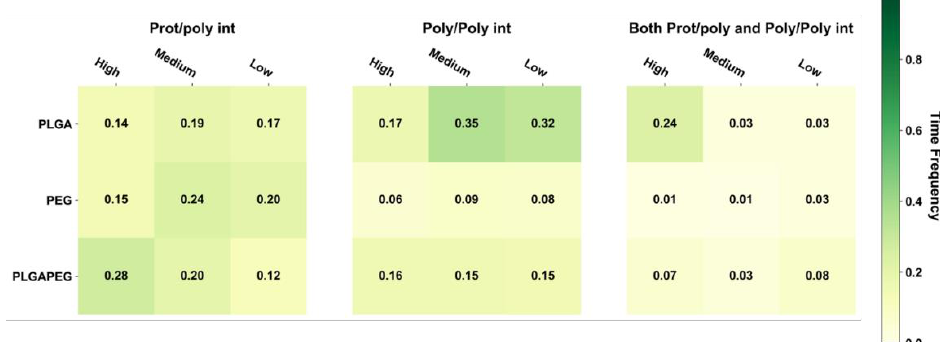
Figure 3. TF poly avg values for each polymer type and interaction class, across different levels of oligomer extension. Time frequency values from simulation trials (n = 7) and oligomers (n = 3/trial) were averaged to arrive at the observed values above.